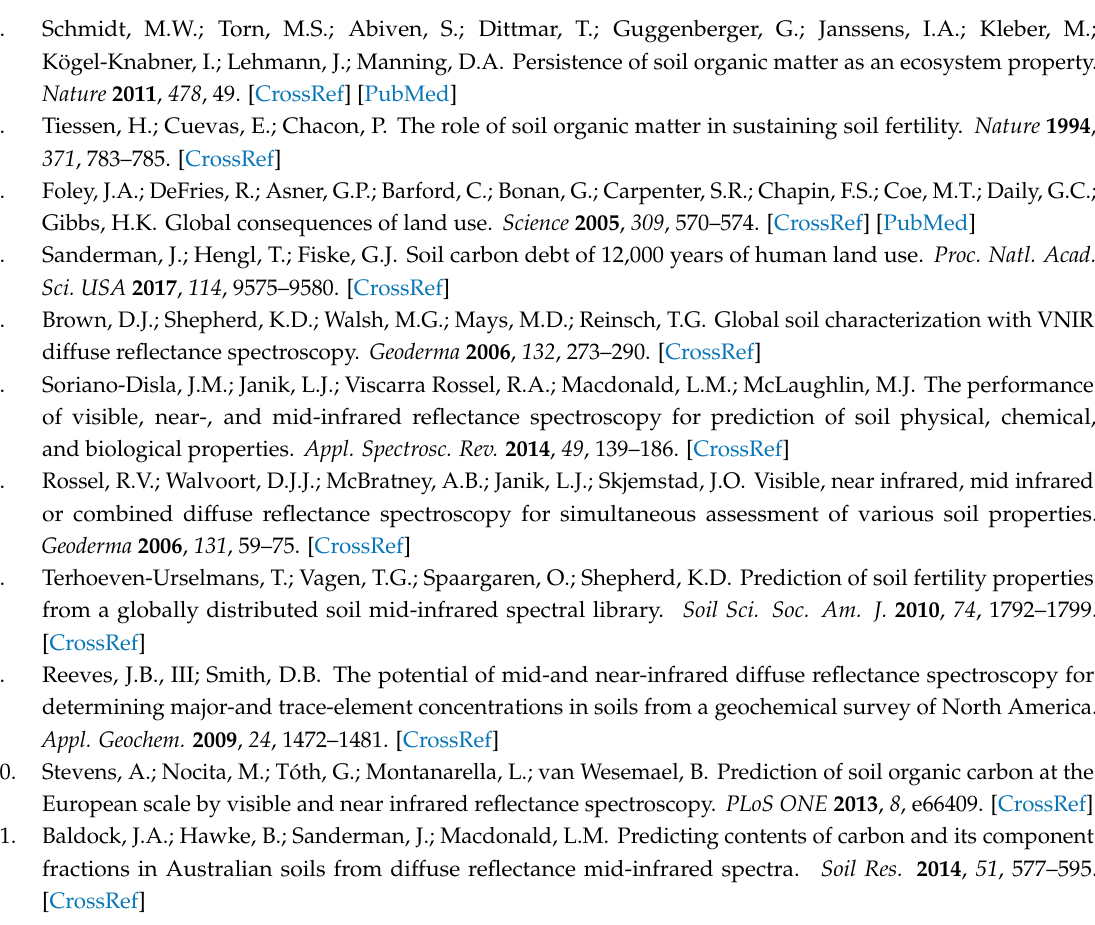
Table S1: Prediction performance of transformed and untransformed OC and pH using global partial least squares regression (PLSR), memory-based learner (MBL), random forest (RF) and Cubist models; Figure S1: Histogram of square-root-transformed soil properties; Figure S2: Comparison of predicted vs observed values using PLSR models for box-cox-, square-root- and log-transformed and untransformed OC and pH; Figure S3: Histogram of square-root-transformed Al, Ca, CEC, clay, CO 3 , Fe, OC, OCD and pH; Figure S4: Histogram of square-root-transformed bulk density using core, clod and combined methods; Figure S5: Outlier detection using PLSR models for OC and Fe; Figure S6: Comparison of predicted vs laboratory estimates of soil properties using RF models; Figure S7: Comparison of predicted vs laboratory estimates of soil properties using MBL models; Figure S8: Comparison of predicted vs laboratory estimates of soil properties using global PLSR models; Figure S9: Comparison of predicted vs laboratory estimates of BD using core, clod and combined core and clod methods; Figure S10: Absolute model error and uncertainty estimates (deviation) of independent validation sets for BD using MBL, PLSR, RF and Cubist models; Figure S11: Model error (observed—predicted values) for the poorest OC predictions using memory-based learner (MBL) and Cubist; Figure S12: Neighbor selection using the memory-based learner; Figure S13: Samples flagged as untrustworthy for OC